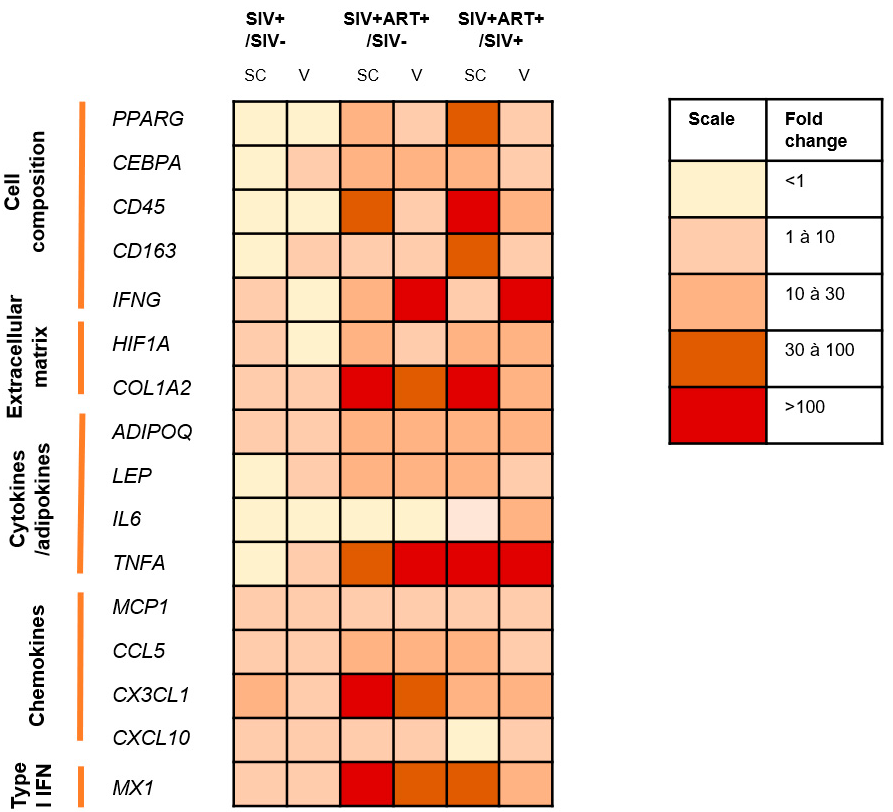
Figure 7. Summary of observed differences in cell composition, inflammatory profile, chemokine expression and interferon-stimulated gene expression within SCAT and VAT. Level of changes (ratio of expression medians) in cell composition, inflammatory profile, chemokine and ISG expression within SCAT and VAT are shown by color gradient for the SIV+/SIV − , SIV+ART+/SIV − , and SIV+ART+/SIV+ groups (expression scale on the right of the table). Each group was compared with the two others.